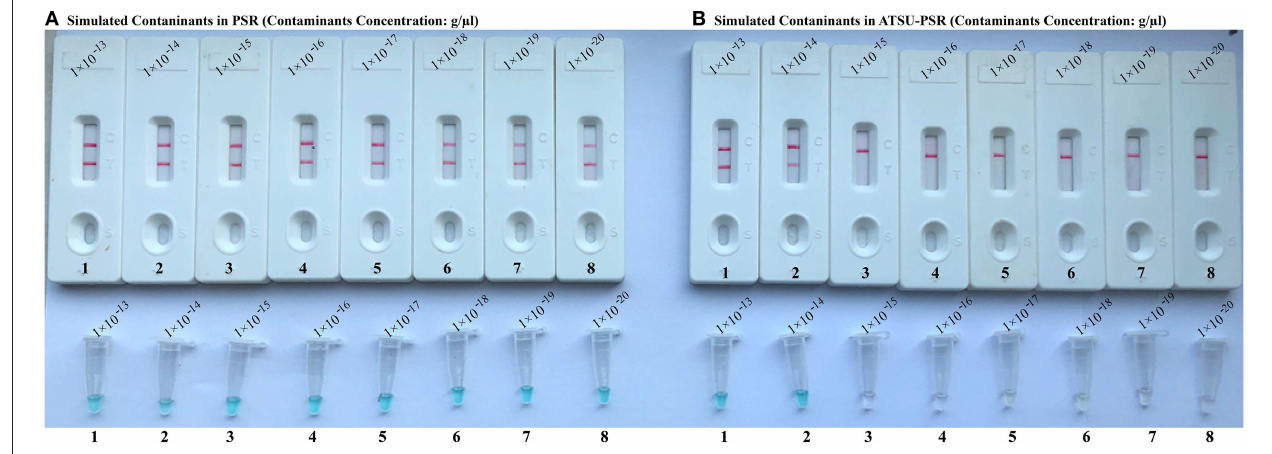
FIGURE 4 | Control of carryover contamination in uracil-DNA-glycosylase-supplemented polymerase spiral reaction (ATSU-PSR) assay. Sensitivity of PSR (A) and ATSU-PSR (B) using serial dilution of simulated carryover contamination (dUTP-incorporated PSR amplicons, concentration diluted from 1 × 10 − 13 , 1 × 10 − 14 , 1